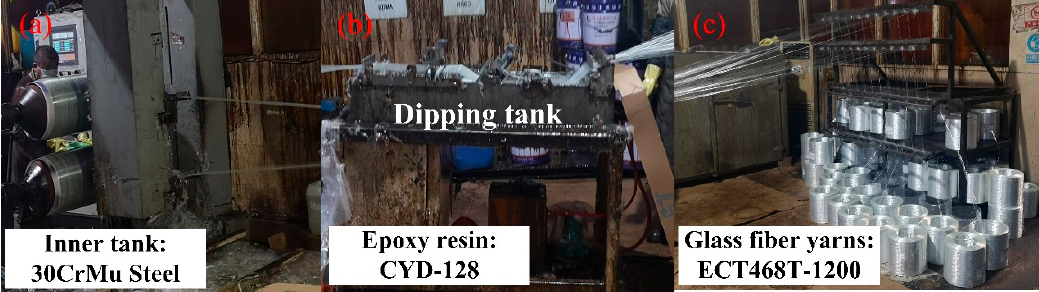
Figure 2. The manufacture processing of the filament wound composite pressure vessel: ( a ) is the rolling tank, ( b ) is the dipping tank, and ( c ) is the glass fiber yarns.